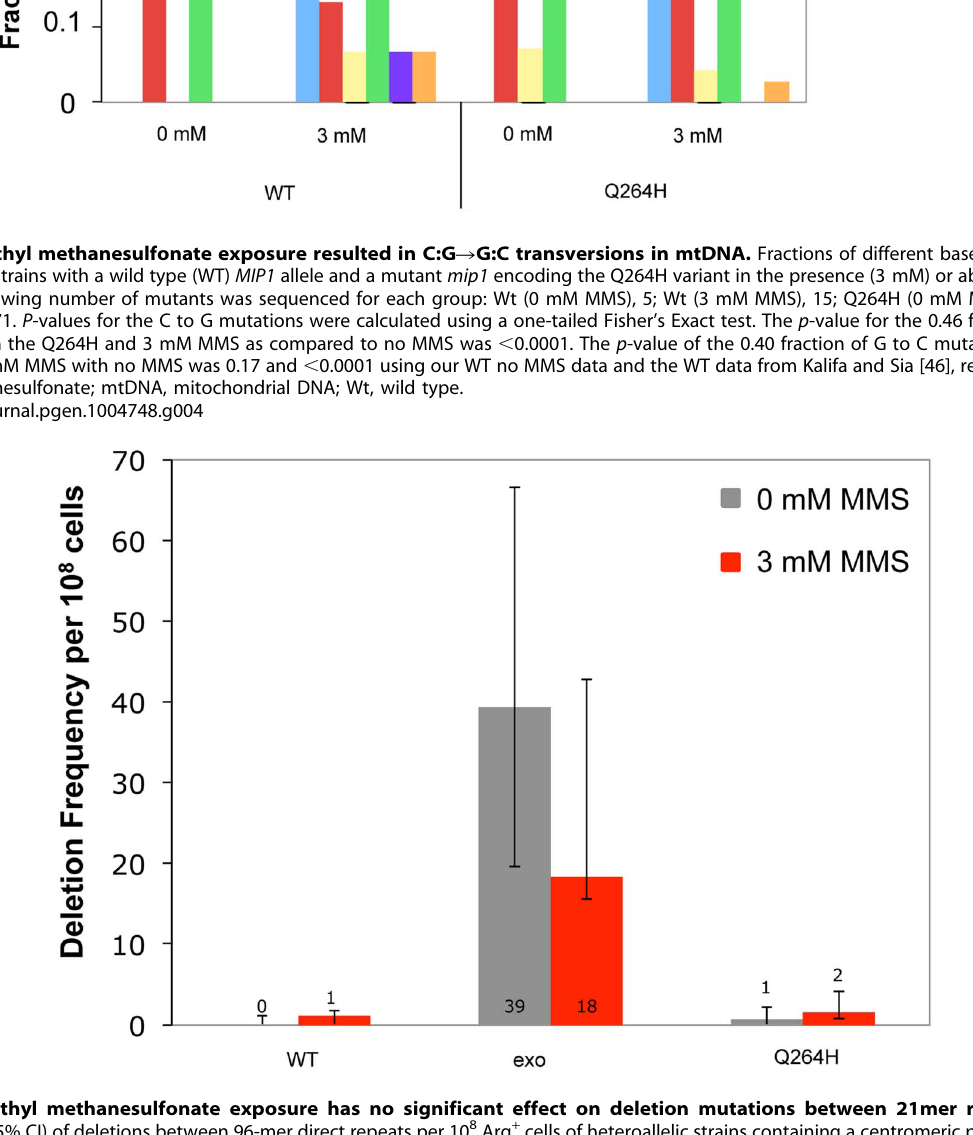
PLOS Genetics | www.plosgenetics.org 7 October 2014 | Volume 10 | Issue 10 |